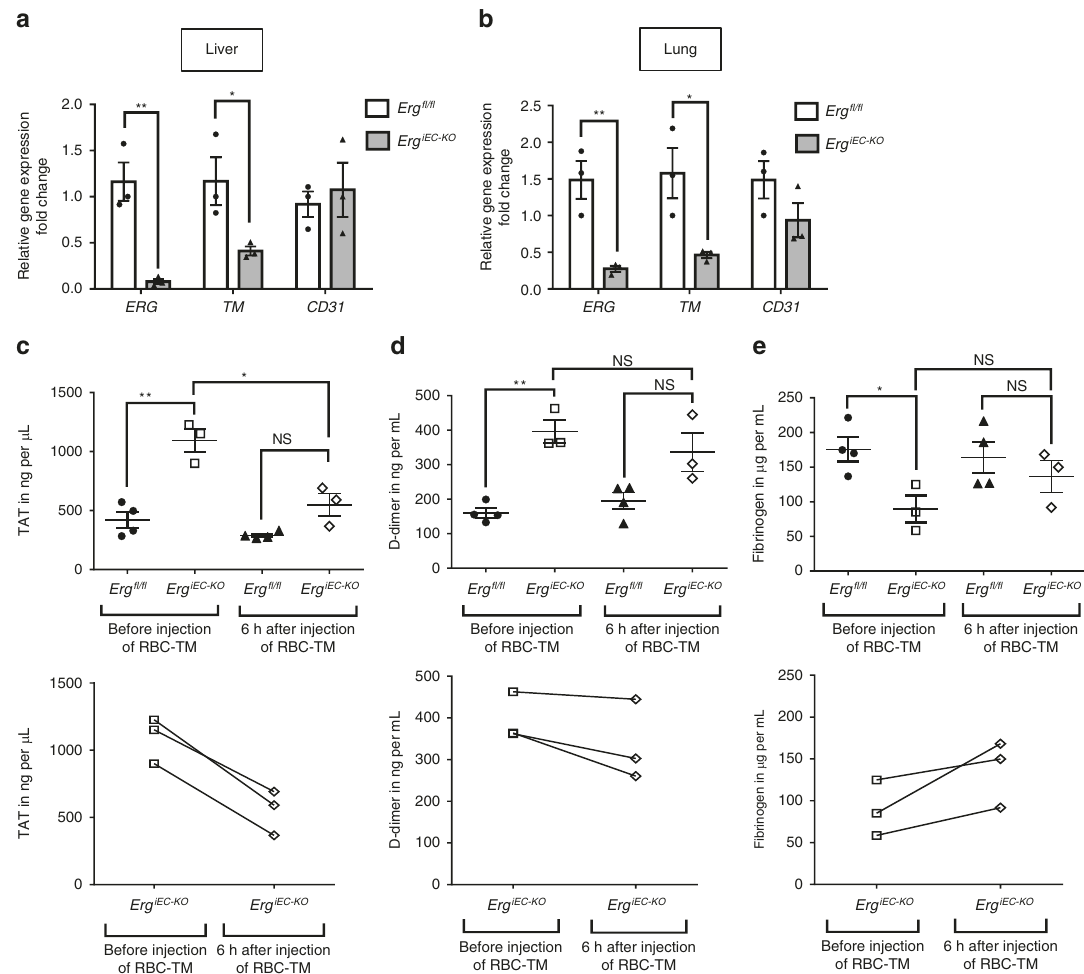
Before injection 6 h after injection of RBC-TM Fig. 3 Treatment with RBC-thrombomodulin rescues the thrombotic phenotype of Erg iEC-KO mice. a , b qPCR analysis of ERG , CD31 and TM gene expression in whole a liver and b lung lysates from adult control ( Erg fl / fl ) and ERG-de fi cient ( Erg iEC-KO ) mice ( n = 3); 25 days after tamoxifen injection and 6 h after RBC-TM injection. Data were normalized to 18S. Graphical data are mean ± s.e.m., * P < 0.05, Student ’ s t -test. c – e Adult Erg iEC-KO and control mice were bled before and after (6 h) injection of red blood cells-targeted thrombomodulin (RBC-TM, 4 mg per kg) to analyse plasma markers for coagulopathy. a Thrombin-antithrombin (TAT) complex concentration (ng per µ L) was measured on plasma from Erg iEC-KO and Erg fl / fl mice, using mouse TAT ELISA kit ( n = 3 – 4 per genotype). b D-dimer concentration (ng per mL) was measured on plasma from Erg iEC-KO and Erg fl / fl mice, using mouse D-dimer ELISA kit ( n = 3 – 4 per genotype). c Fibrinogen concentration ( µ g per mL) was measured on plasma from Erg iEC-KO and Erg fl / fl mice, using mouse Fibrinogen ELISA kit ( n = 3 – 4 per genotype). All graphical data are mean ± s.e.m., NS: Not signi fi cant, * P < 0.05, ** P < 0.01, Student ’ s t -test. Data for each Erg iEC-KO mouse before and after RBC-TM injection are also presented in separated graphs (bottom graphs) to see individual response to the treatment. Source data are provided as a Source Data fi